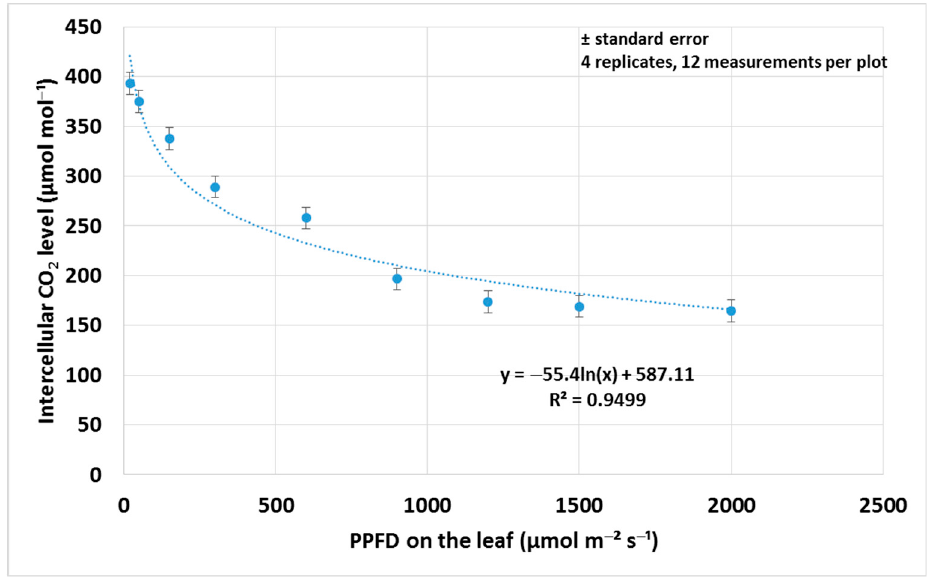
Figure 5. Intercellular CO 2 level light curve in winter barley, average of cultivars, 26 May (BBCH 73–75), N 90 P 45 K 50 (Debrecen, 2020) 4 replicates, 12 measurements (2 leaves, 6 recordings per leaf). Increasing PPFD resulted in decreasing intercellular CO 2 level caused by stomata closing. The change was especially expressed from 20 to 900 µmol m − 2 s − 1 PPFD levels. PPFD: photosynthetic photon flux density.